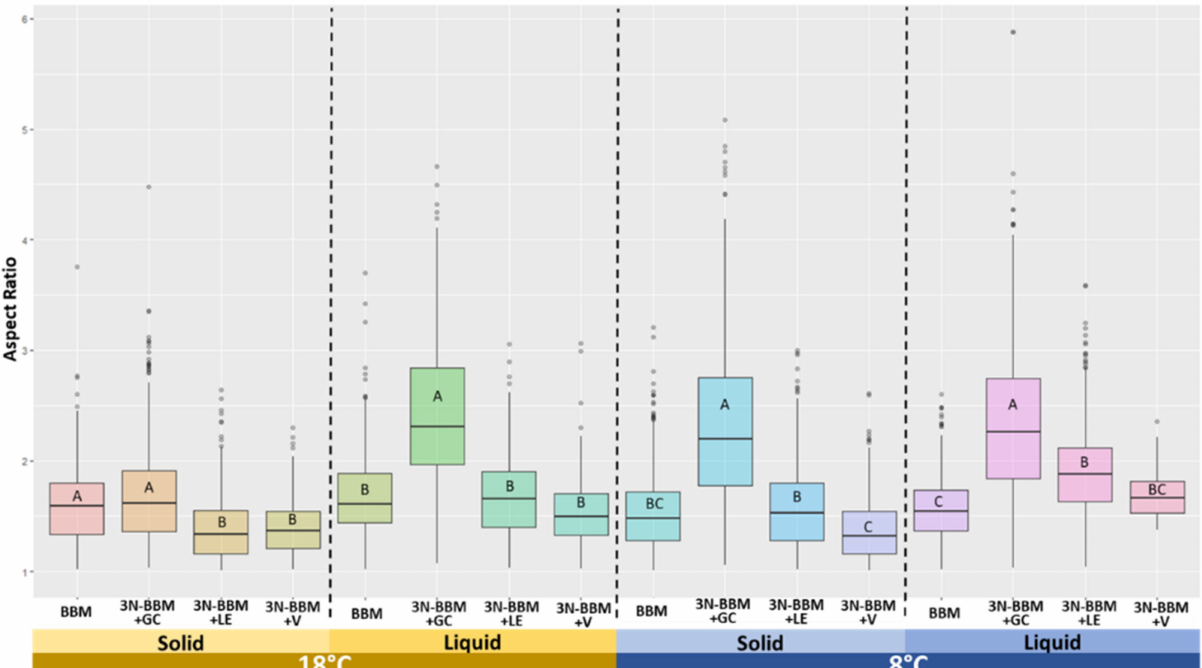
Figure 6. Boxplot of aspect ratio measurements to assess the morphology and phenotypic plasticity for each treatment. Combinations of temperature conditions and types of media are separated by dashed lines. Different letters indicate significant differences (Tukey test, p < 0.05) between culture media inside each combination of temperature and type of medium. The aspect ratio was calculated as Feret diameter (longest internal diameter)/longest internal diameter perpendicular to the Feret